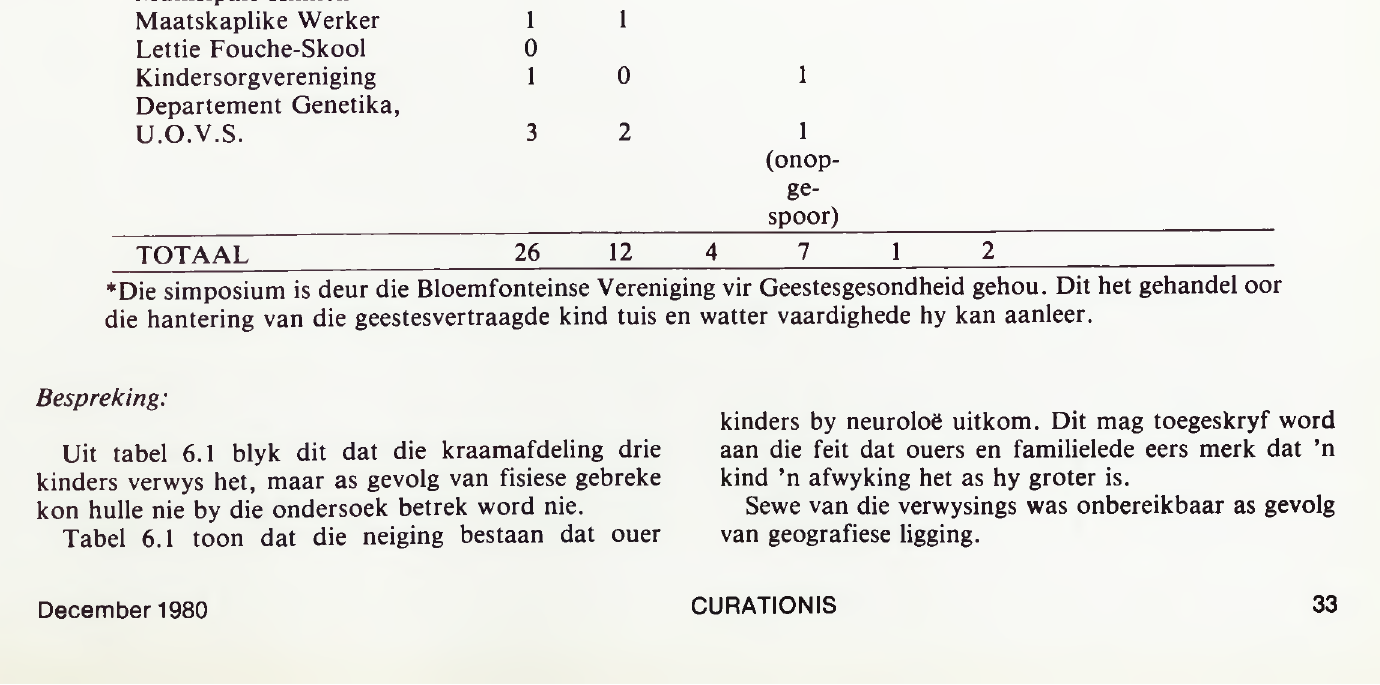
TABEL 6.1: AANTAL KINDERS OPGESPOOR